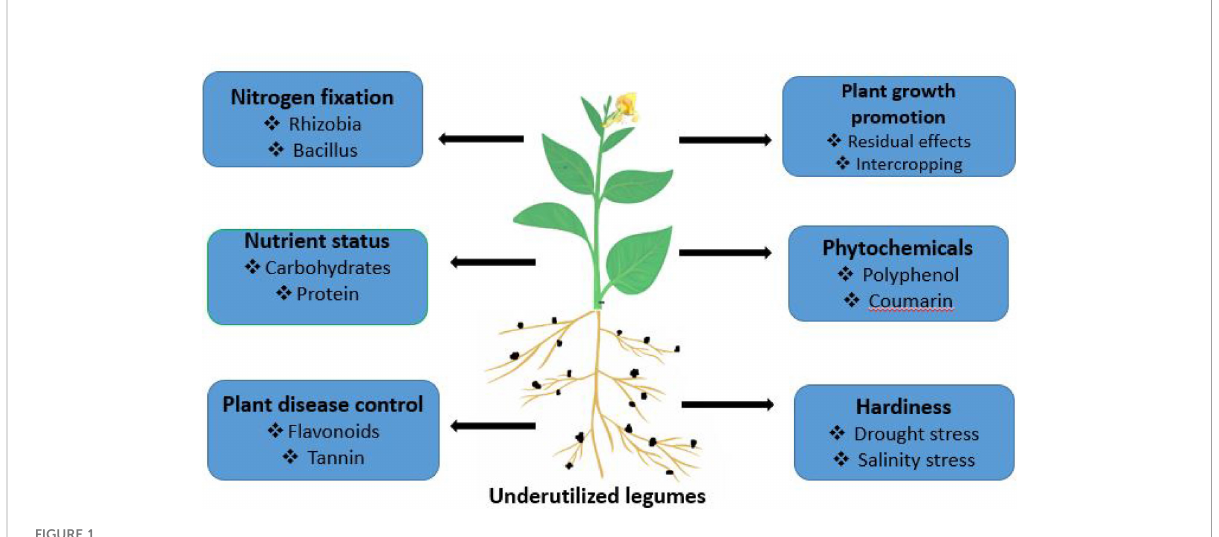
FIGURE 1 Mechanism of underutilized legumes in food security